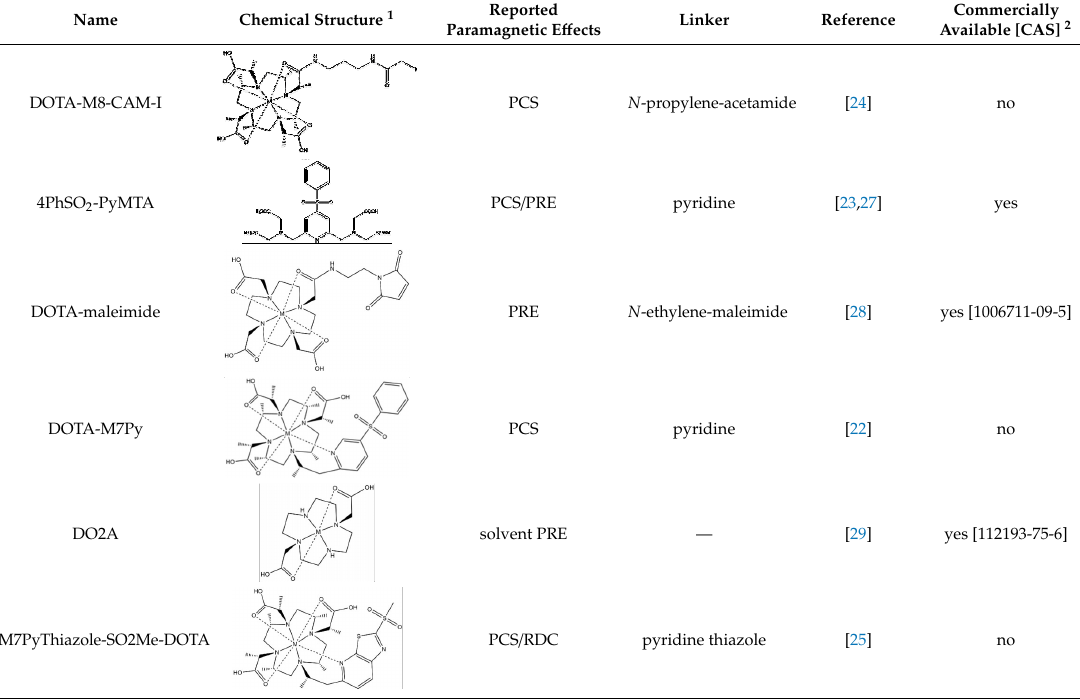
Table 1. Lanthanide-binding tags (LBTs) proposed for inducing paramagnetic effects in living cells.